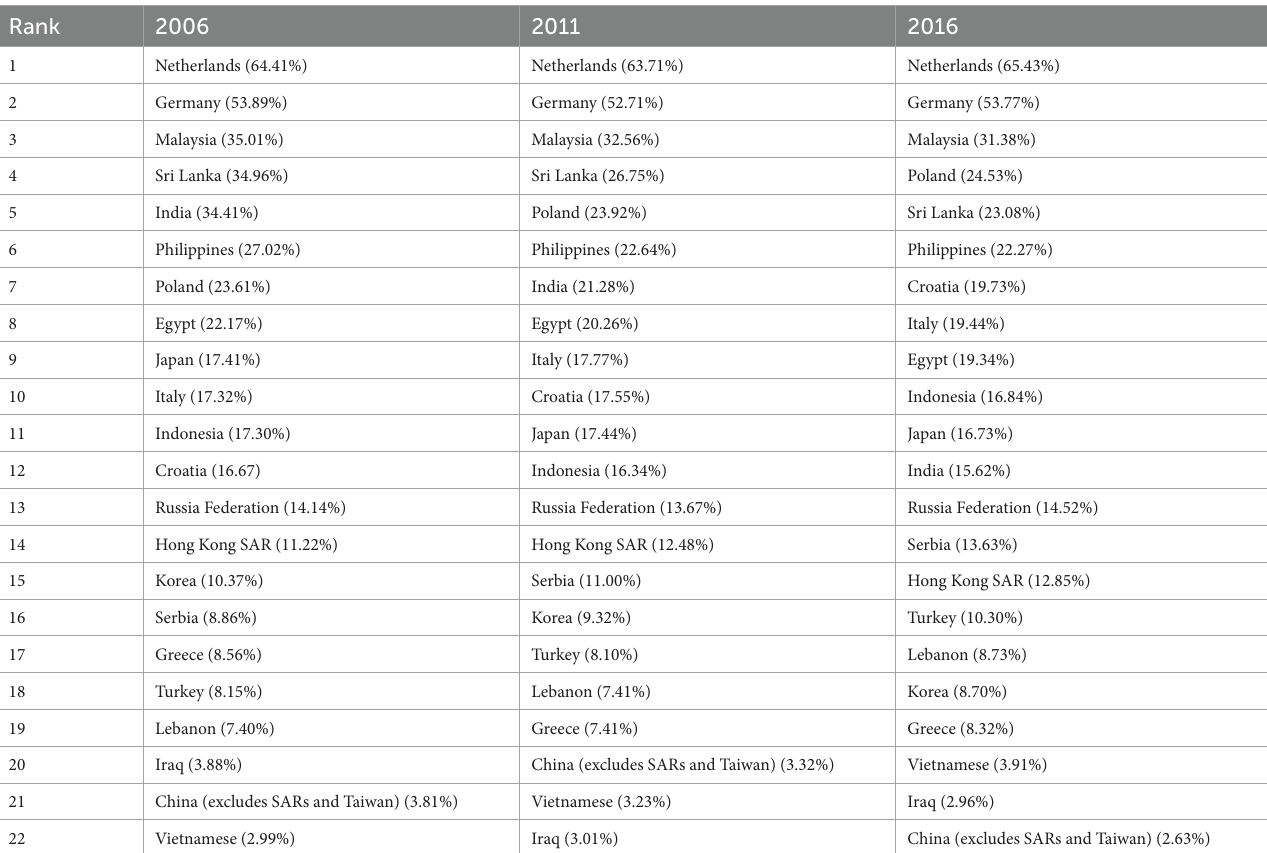
TABLE 4 Language shift of the first generation by country of birth in 2006, 2011, 2016.